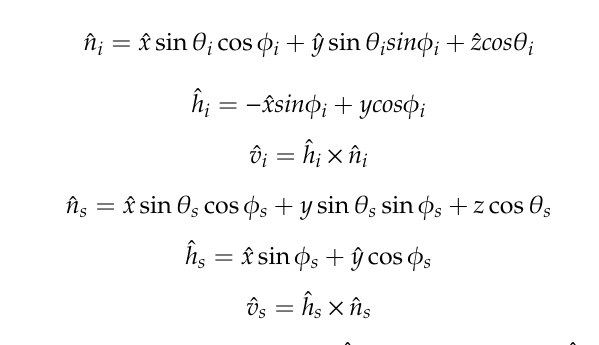
Figure 1. Geometry for the Forward Scatter Alignment (FSA) coordinate system.